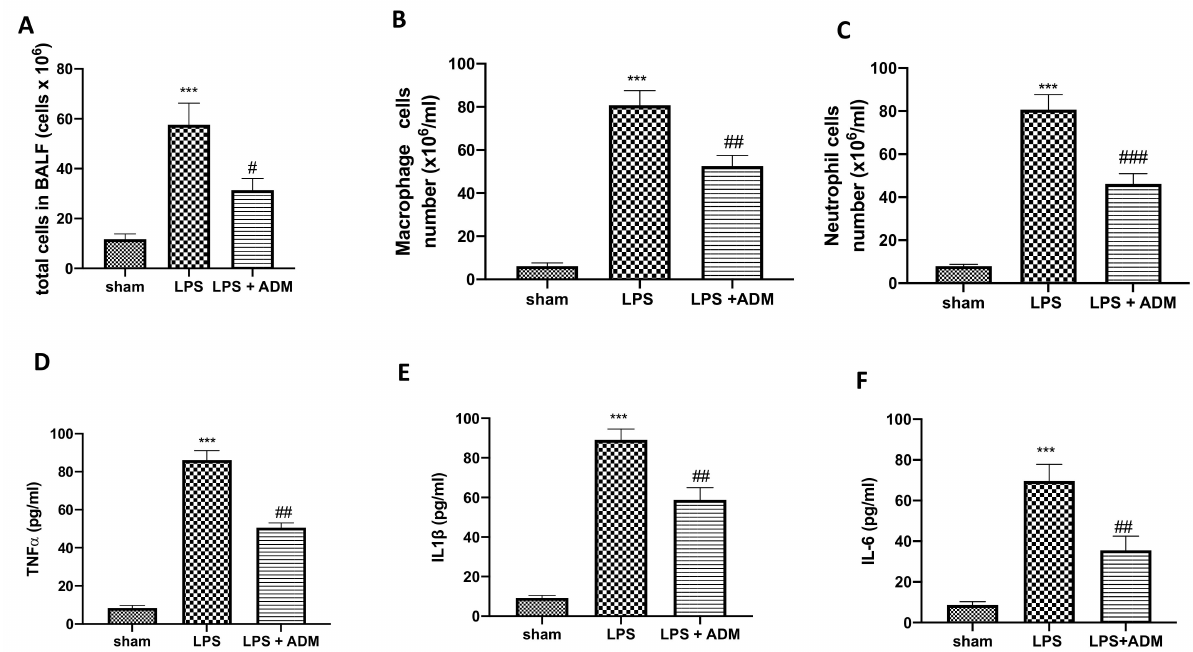
Figure 2. Cell infiltration expression in BALF. Total cell number ( A ), Macrophages ( B ), Neutrophils ( C ). Expression of proinflammatory cytokine: TNF- α ( D ), IL-1 β ( E ), IL-6 ( F ). Data are expressed as the mean ± SEM of N = 6 mice/group. *** p < 0.001 vs. sham; # p < 0.05 vs. LPS; ## p < 0.01 vs. LPS; ### p < 0.001 vs.